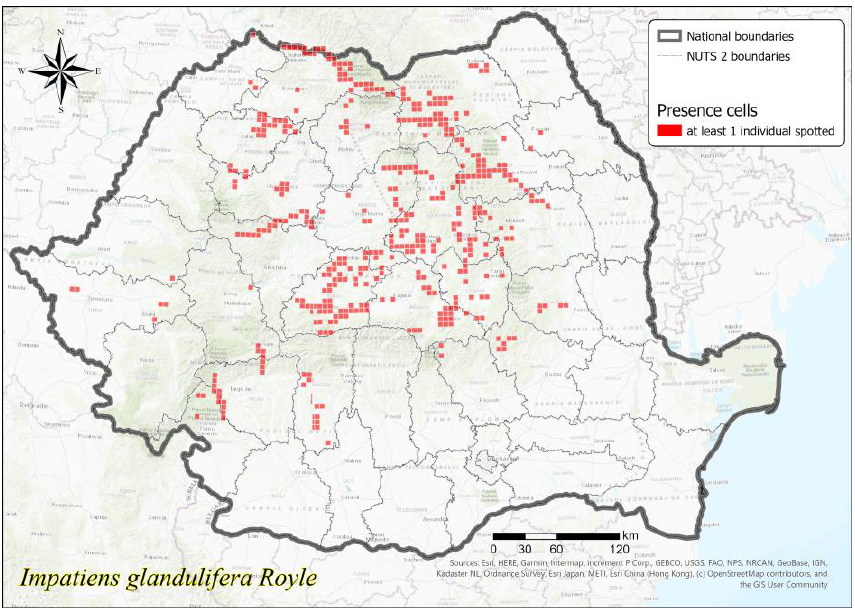
Fig. 7. Impatiens glandulifera occurs along rivers, especially in mountain